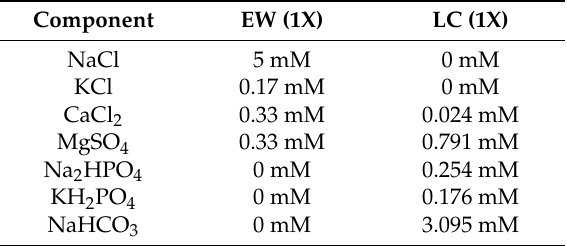
Table 1. Composition of egg water (EW) and low chloride (LC) medium